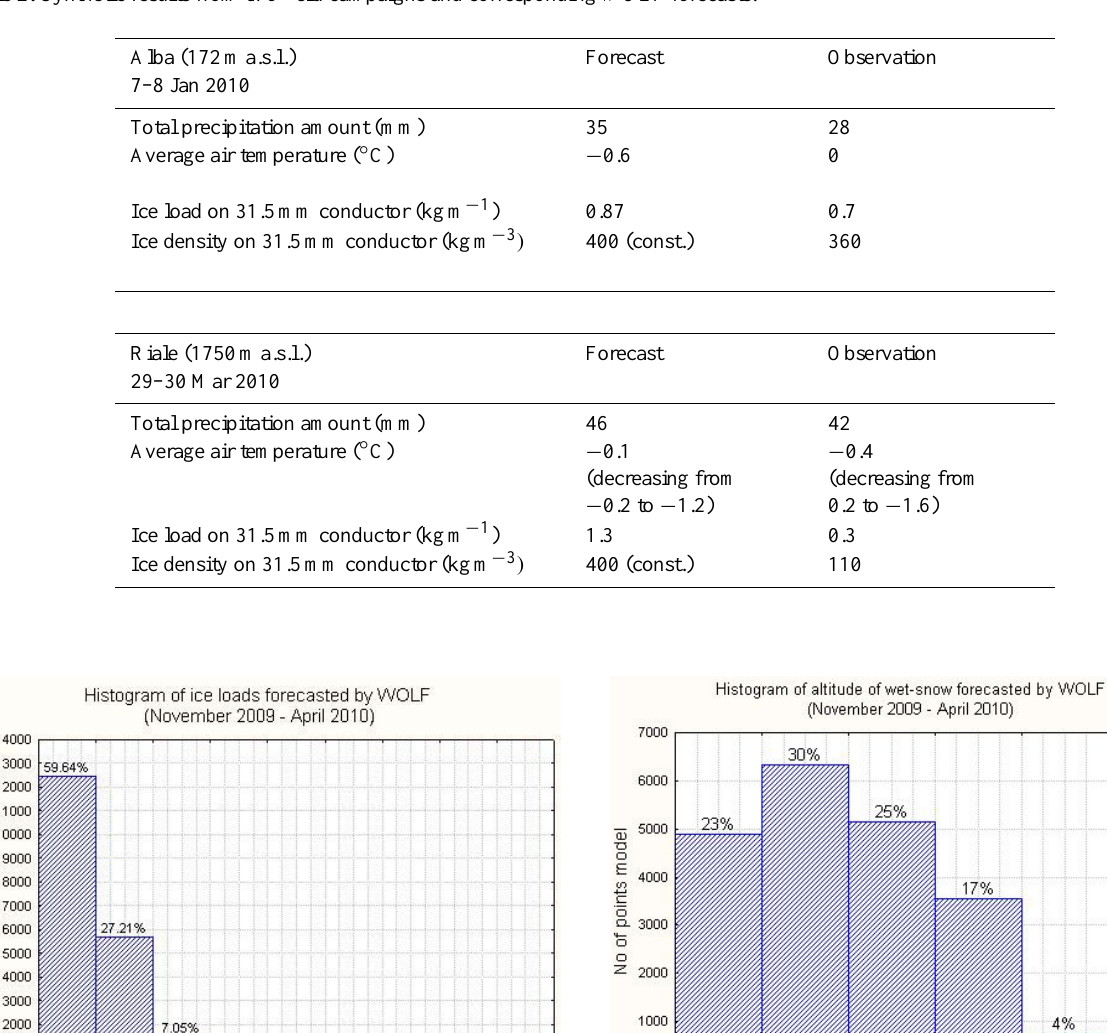
Table 2. Synthetic results from two field campaigns and corresponding WOLF forecasts.